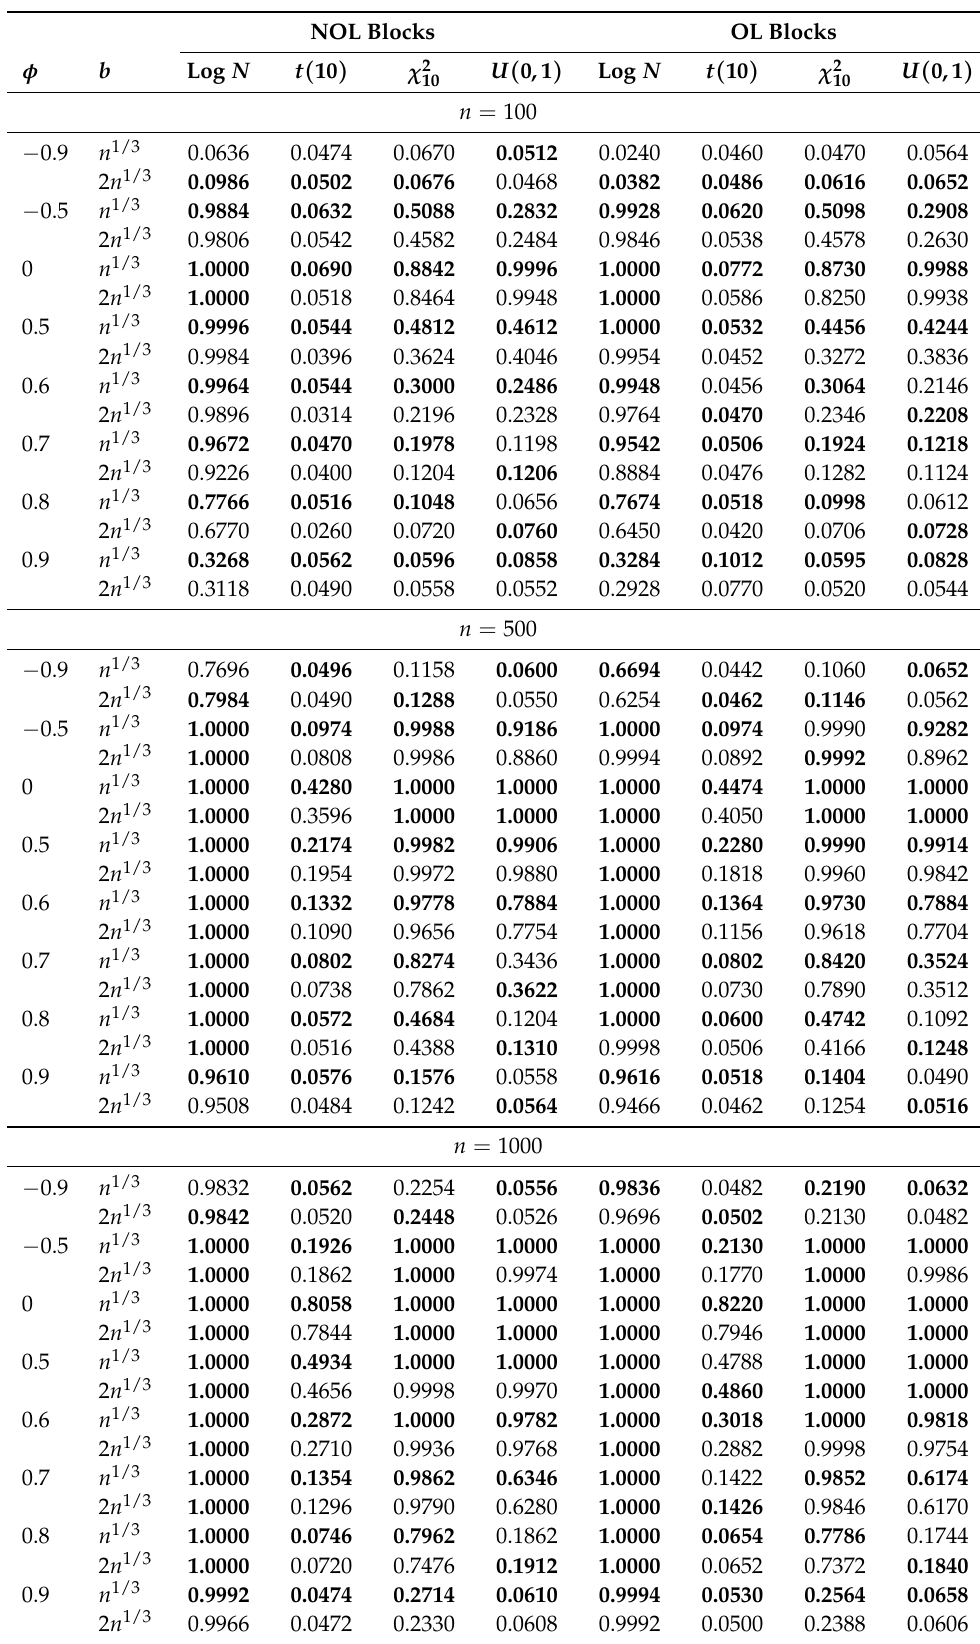
Table 3. Empirical rejection probabilities of the process defined in (10) for NOL and OL blocks